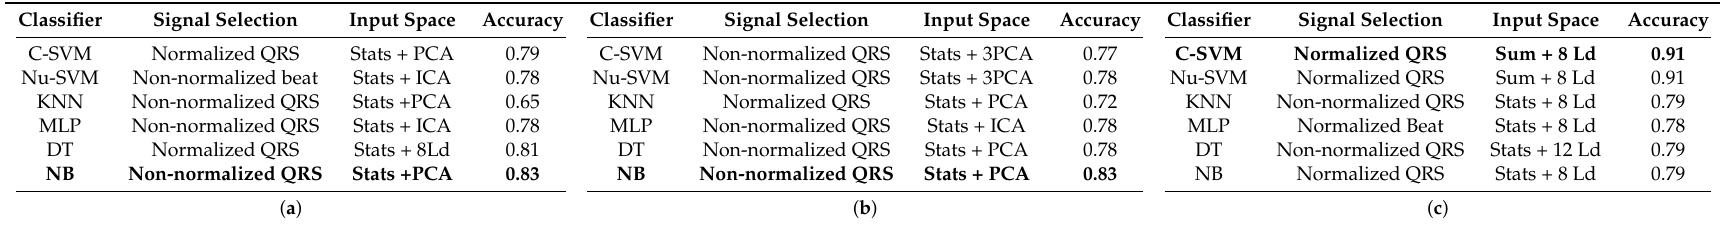
Table 3. Accuracy for the best classification method of each proposed non-linear classifier applied over the fragmentation databases. ( a ) Sfrag-DB. ( b ) SWfrag-DB. ( c )